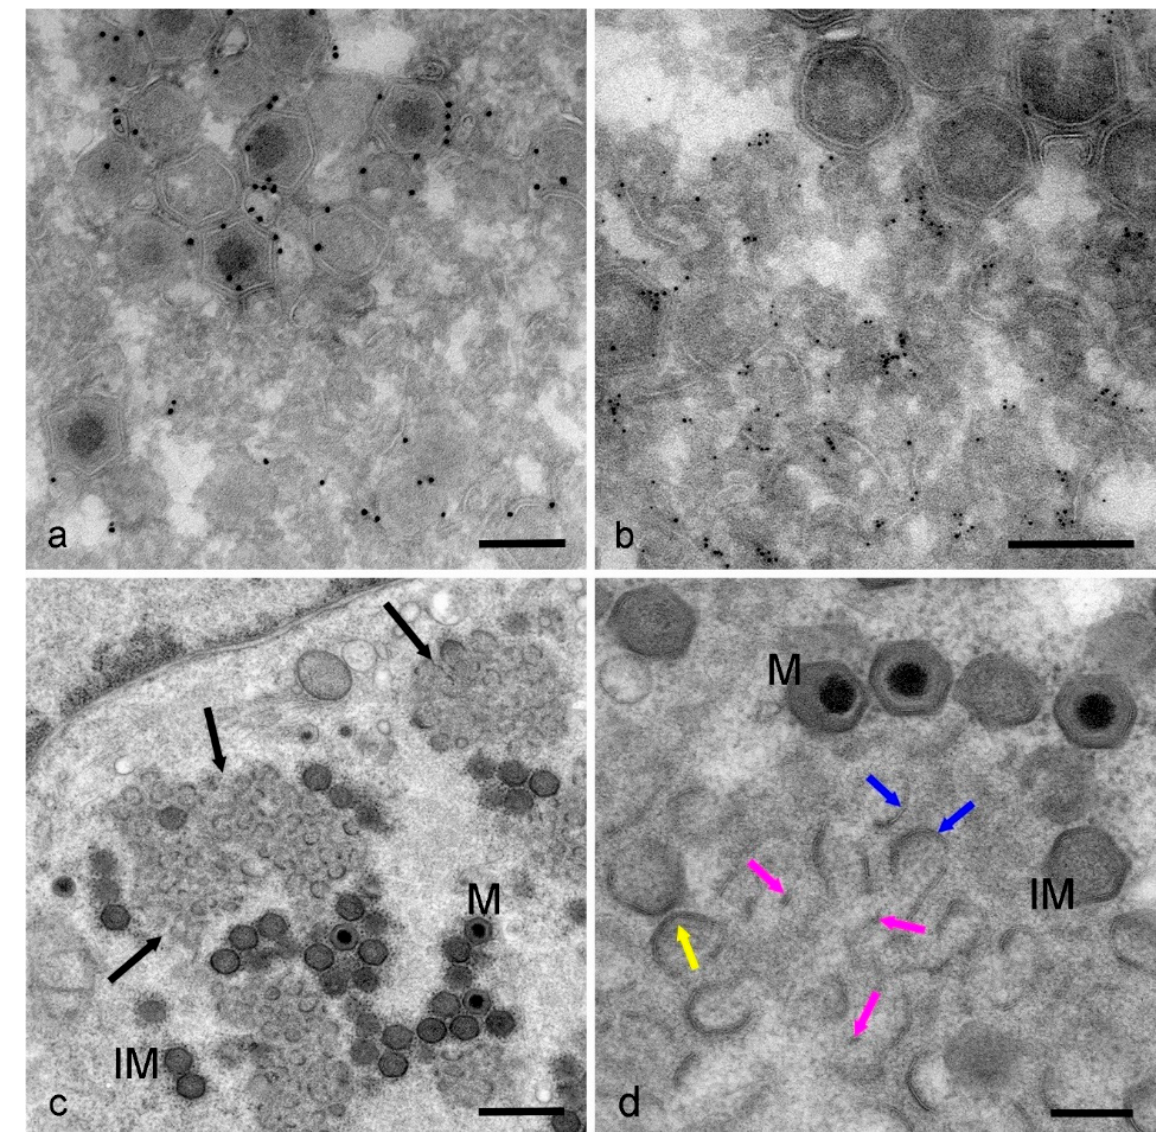
Figure 4. Transmission electron microscopy of viral factories in Vero cells at 18 hpi. Immunogold labelling of cryosections with antibodies against ( a ) p72 (4H3 antibody) with 10 nm gold and ( b ) p54 (RB7 antibody) with 5 nm gold. 10 nm gold clearly and distinctly localizes to whole virions whereas 5 nm gold localizes to the membrane assembly intermediates. ( c ) A low power image of high-pressure frozen (HPF) infected cells displays the different structures within a factory. Immature (IM) and mature (M) virions are visible surrounding darker areas of protein containing membrane assembly intermediates (black arrows). ( d ) At higher power, it is possible to identify different forms of membrane assembly intermediates; membrane fragments (pink arrows), larger curved membranes (blue arrows) and more mature intermediates with capsid and core protein and the beginnings of the icosahedral angles (yellow arrow). Scale bars: a, b, d = 200 nm, c = 500 nm. The 3D model of part of this reconstruction (Figure 5c,d) shows a circular, part-formed virion connected by a membrane ribbon to another part-formed virion (Figure 5c,d, white arrow). The icosahedral shape had not started to form yet. Isolated membrane fragments are also seen, some small (Figure 5c, pink arrows) and some slightly larger (Figure 5c,d, light blue arrows), suggesting that these fragments grow or coalesce in the factory. When the model is viewed from a different angle, these fragments appear to be associated with each other, forming narrow stacks or ‘bridges’ linking curved membrane assembly intermediates (Figure 5d, dark blue